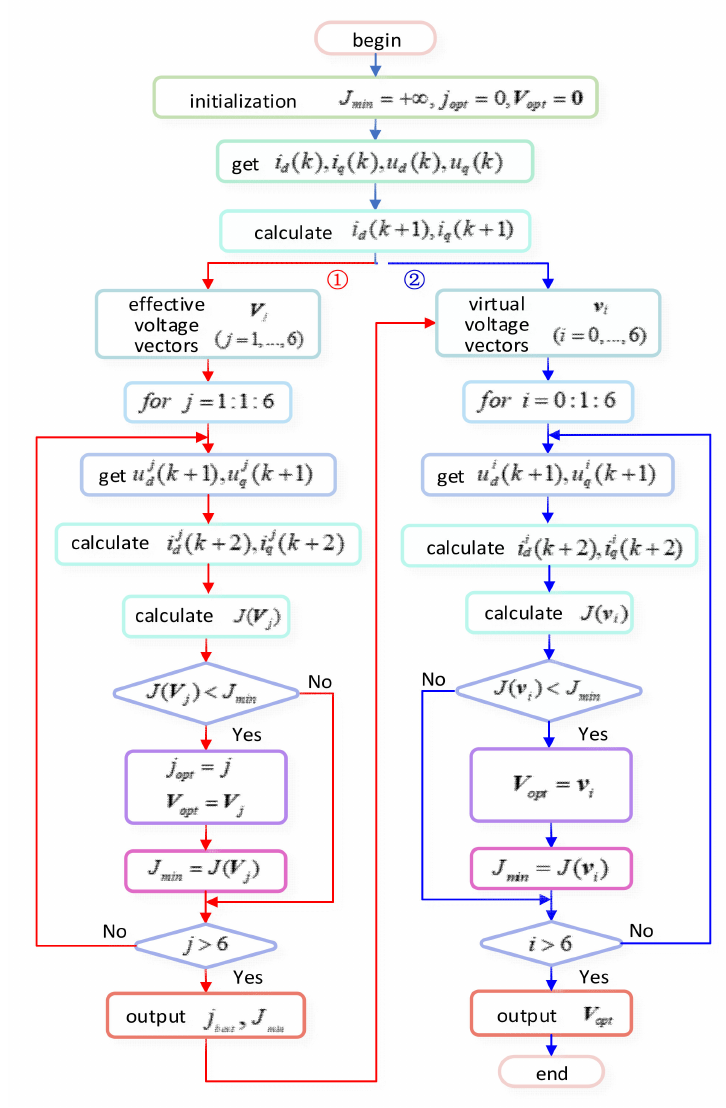
Figure 4. The procedure to select the optimal voltage